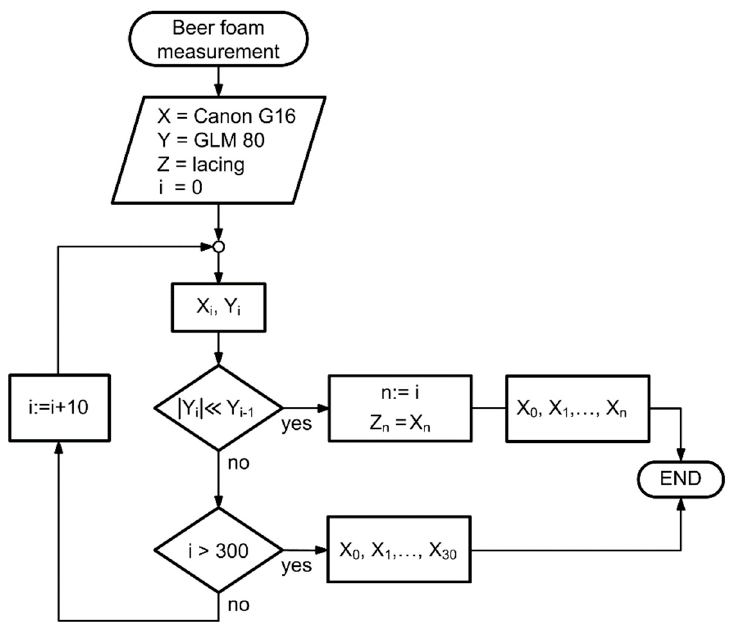
Figure 10. Algorithm used for beer foam analysis and determination of lacing.